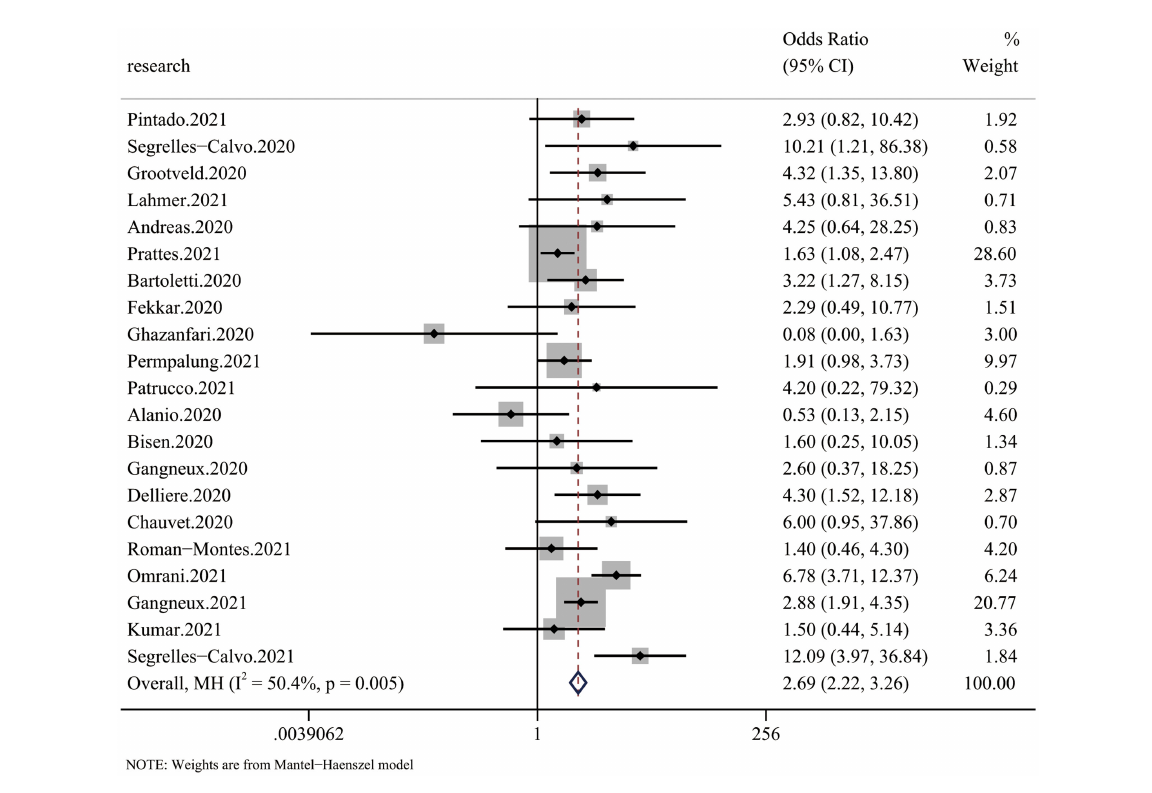
outcomes. Although data to calculate the pooled outcome